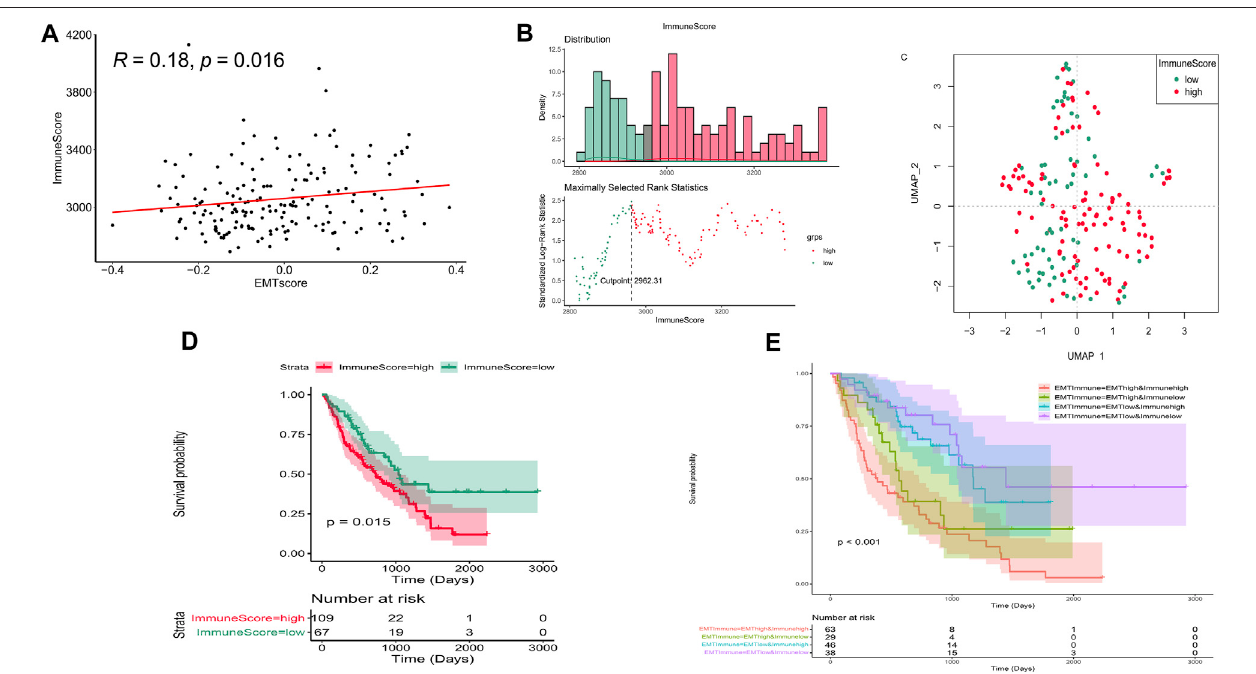
FIGURE 3 | Immune score affect the prognosis of IPF in the training set. (A) Correlation between the EMT and immune scores. (B) Optimal cutting point analysis suggested that the optimal cutting point of the immune score was equal to 2,962.31 in the training set. Green represents low score of immune, and red represents high score of immune. (C) UMAP cluster of IPF patients in the training set based on immune-related genes. (D) Survival curve of high- and low-immune score groups. (E) Survival curve of high- and low-EMT and immune score groups.